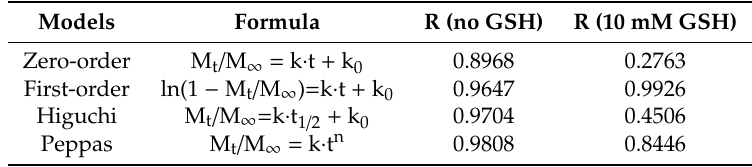
Figure 8. Flow cytometry analysis of the specific endocytosis of fluorescein isothiocyanate isomer I (FITC)-labelled HA internalized by ( A ) A549 cells, ( B ) A549 cells pre-treated for 2 h with free HA (2.5 mg/mL), and ( C ) NIH-3T3 cells.